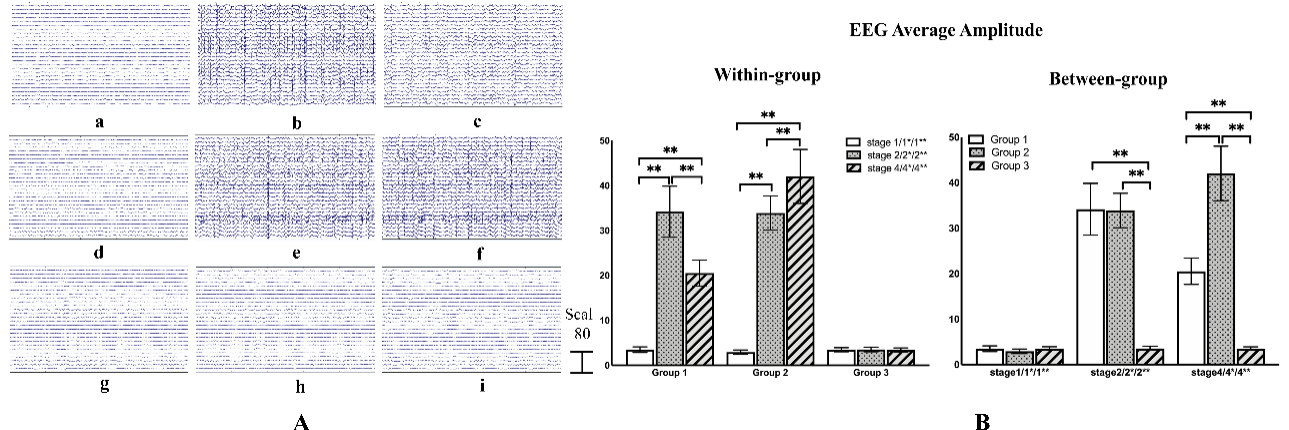
Figure 9. ( A ) ( a – c ) Respectively represent the raw EEG data of Stage 1, Stage 2, and Stage 4 in Group 1. ( d – f ) Respectively represent the raw EEG data of Stage 1*, Stage 2*, and Stage 4* in Group 2. ( g – i ) Respectively represent the raw EEG data of Stage 1 **, Stage 3**, and Stage 4** in Group 3. ( B ) Within-group comparisons and between-group comparisons of EEG average amplitude. ** indicates significance ( p < 0.01).